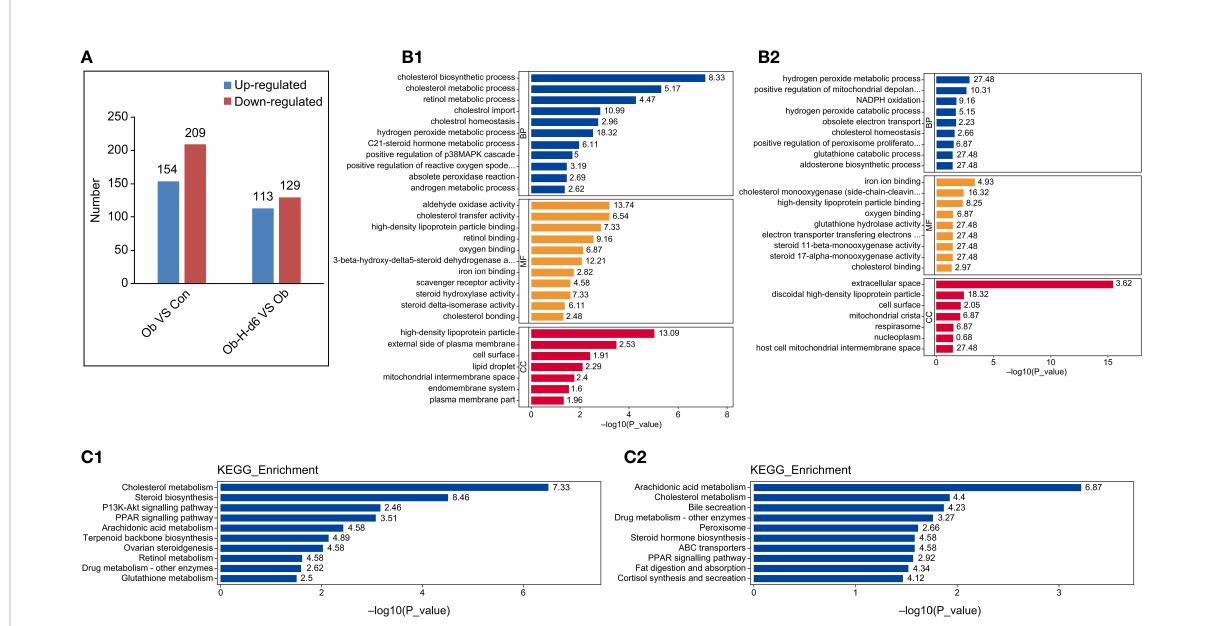
FIGURE 8 Functional and pathway enrichment analysis of DEPs. (A) The distribution of the number of DEPs in histogram (Ob/Con and Ob-H-d6/Ob). Blue and red indicate signi fi cantly upregulated and downregulated DEPs, respectively. (B1, 2) GO functional analysis of DEPs in the Ob/Con and Ob-H-d6/Ob comparison groups. Blue, yellow, and red represent biological process (BP), molecular function (MF), and cellular component (CC), respectively. (C1, 2) KEGG pathway analysis of DEPs (Ob/Con and Ob-H-d6/Ob). Con, Control group; Ob, Obese group; Ob-H, Obese-Hypoxia